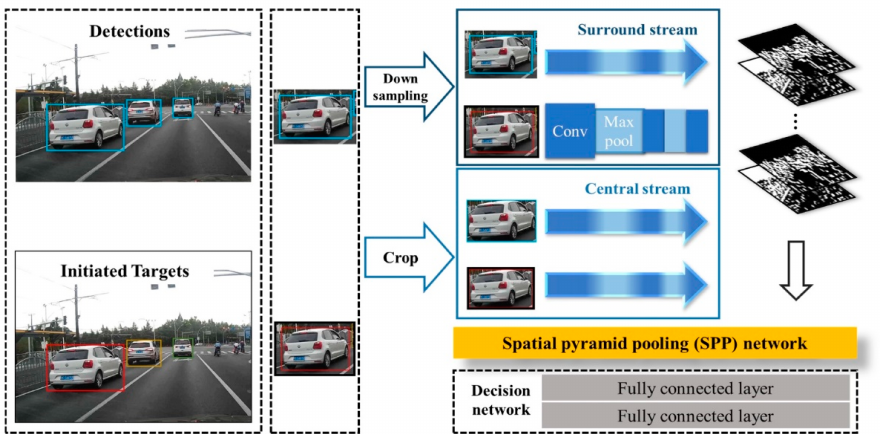
Figure 5. Central-surround two-channel spatial pyramid pooling network (CSTCSPP) based on the Siamese-type architecture (image obtained from